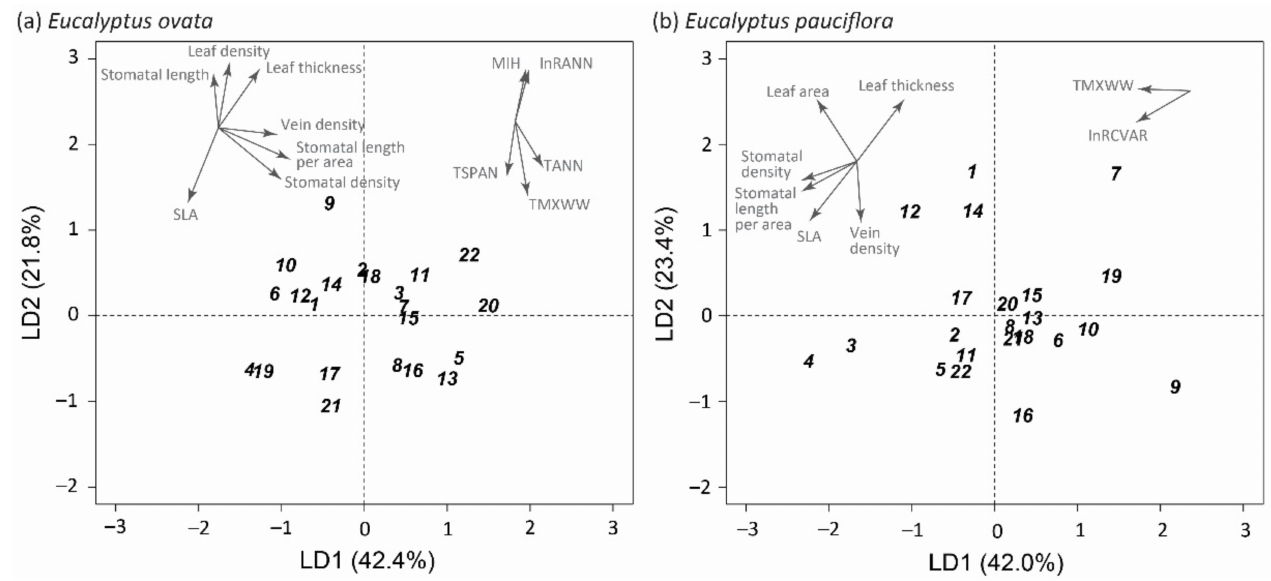
Figure 1. Plots of population centroids in the space defined by the first two axes (LD1 and LD2) derived from separate discriminant analyses of the 22 paired populations of E. ovata (( a ): LD1 42.4%, p = 0.081; LD2 21.8%, p = 0.690) and E. pauciflora (( b ): LD1 42.0%, p < 0.001; LD2 23.4%, p = 0.045). The discriminant analyses were based on the six primary leaf economic and hydraulic traits, and the resulting LD axes are independent maximum variance axes. The direction of trait (primary and com- pound traits) and climate vectors which showed a significant ( p < 0.05) fit into the two-dimensional discriminant space are indicated (See Table S2). The length of each arrow is proportional to the correlation between the ordination and the trait/climatic variable, and the direction of each arrow is the direction of its most rapid change [46]. The population codes (1-22) correspond to the spatially paired populations as detailed in Table